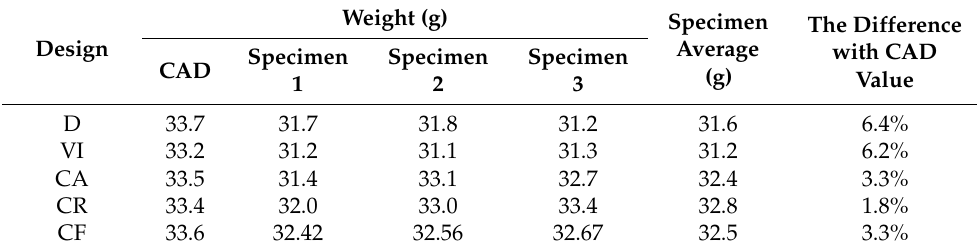
Table 2. Weight of printed samples and comparison with CAD value.